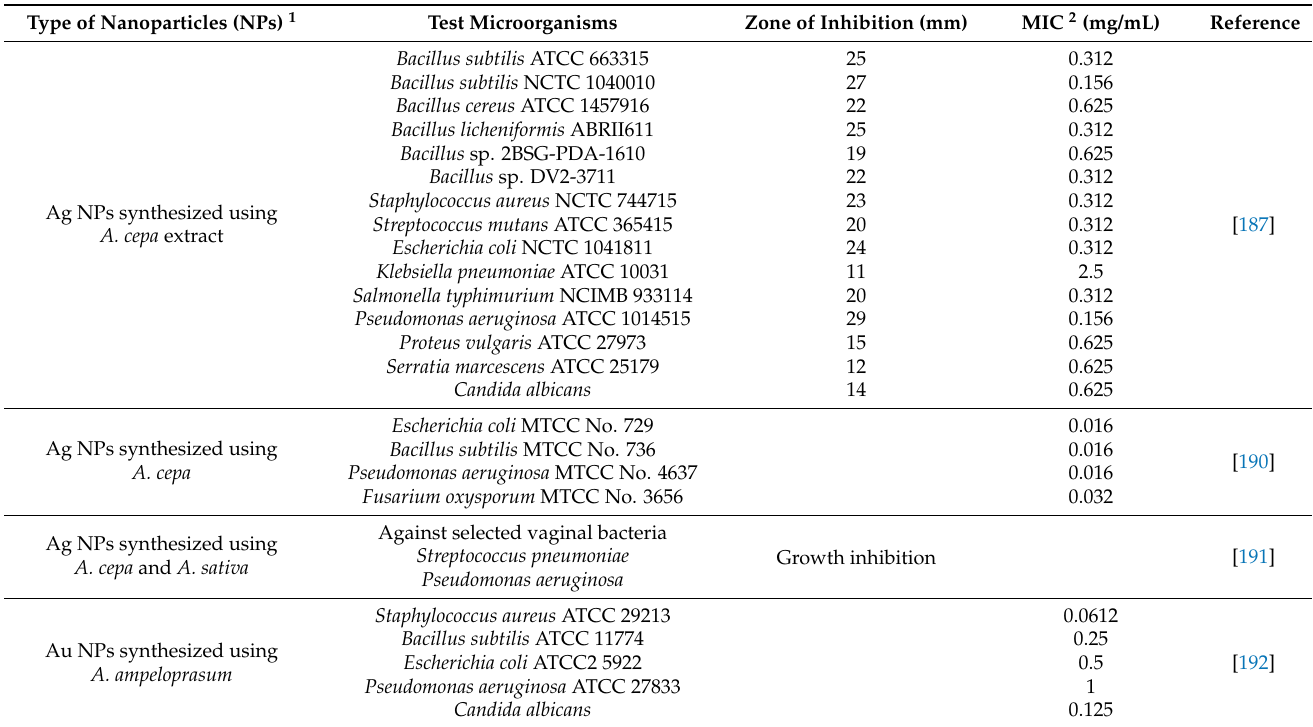
Table 4. Antimicrobial activity studies of different types of metal nanoparticles synthesized using Allium genus plants against different bacteria and fungal